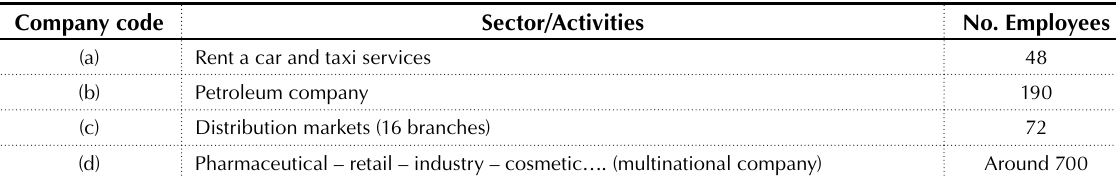
Table 2. Tested sample